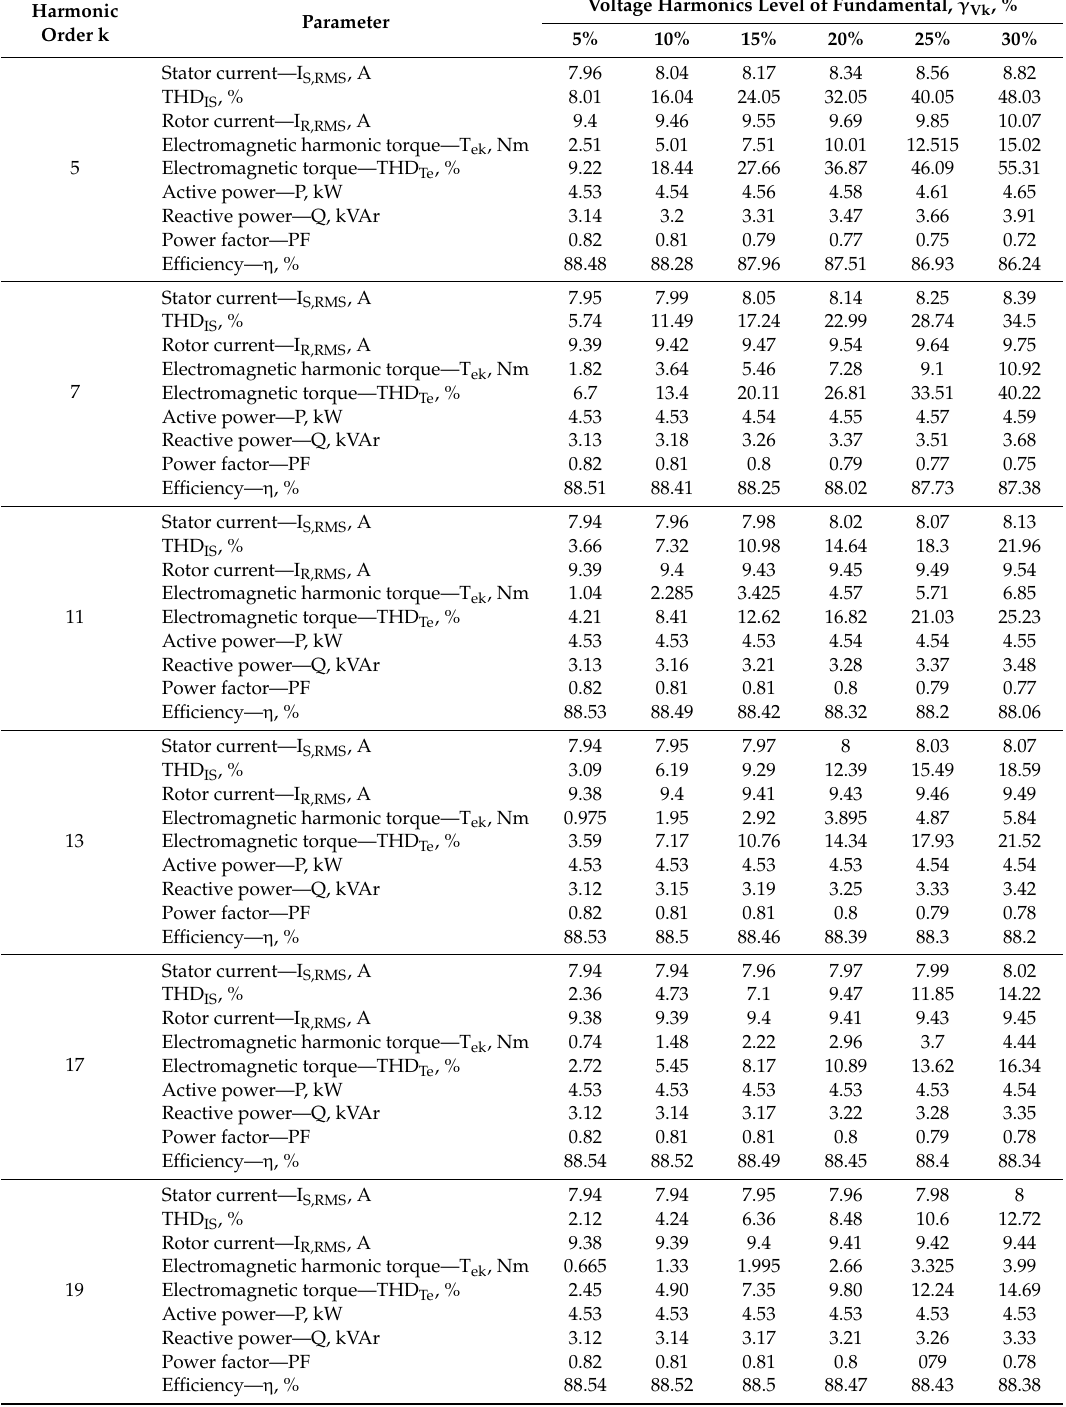
Table 3. Data on the IM behavior in harmonics at rated